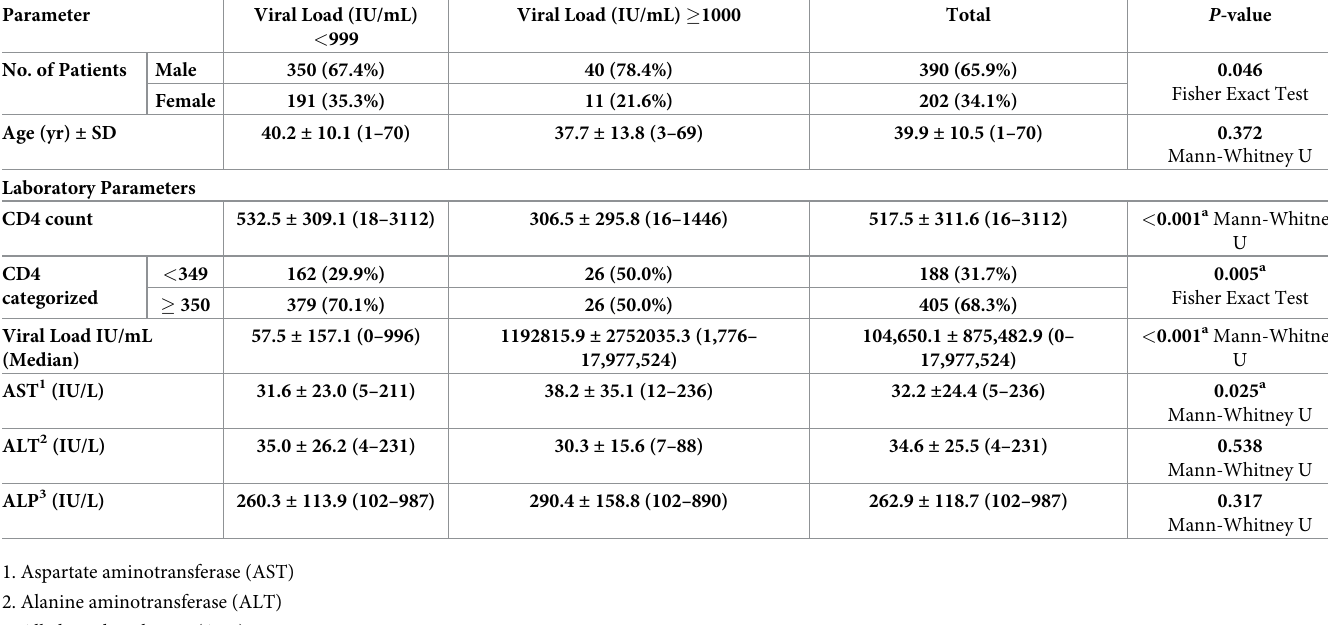
Table 2. Demographic characteristics and laboratory findings of patients with human immunodeficiency virus infection.